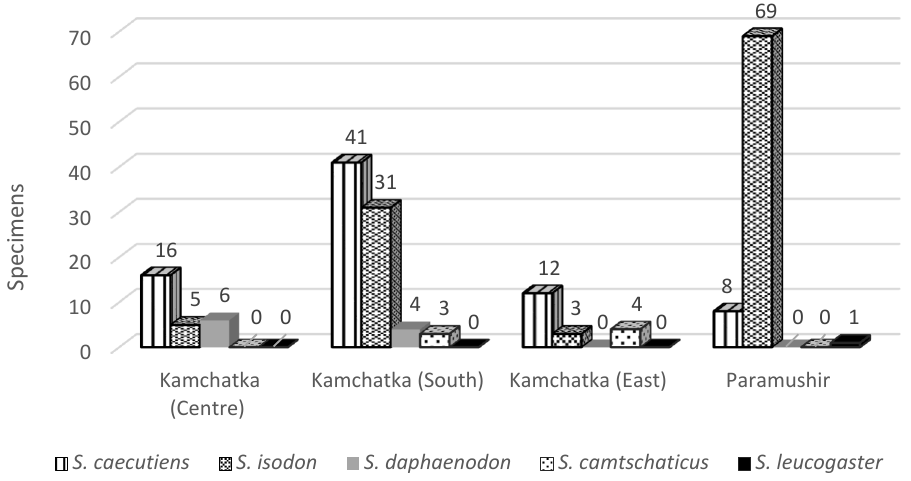
Figure 2. The number of shrews Sorex studied in Kamchatka and Paramushir Island. Helminths found in the intestines of animals were fixed in 70% ethanol. Cestodes were stained with Ehrlich’s hematoxylin and differentiated with a 3% aqueous solution of ferric ammonium sulphate 12-hydrate. Then, they were dehydrated in an ethanol series, cleared in clove oil, and mounted in Canadian balsam. Some fragments of strobila were